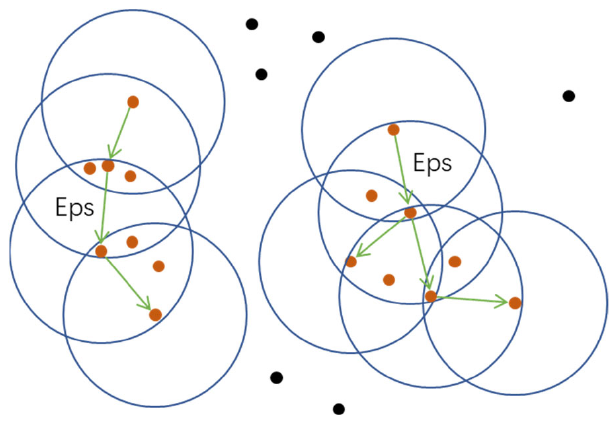
Figure 8. Schematic diagram of DBSCAN.